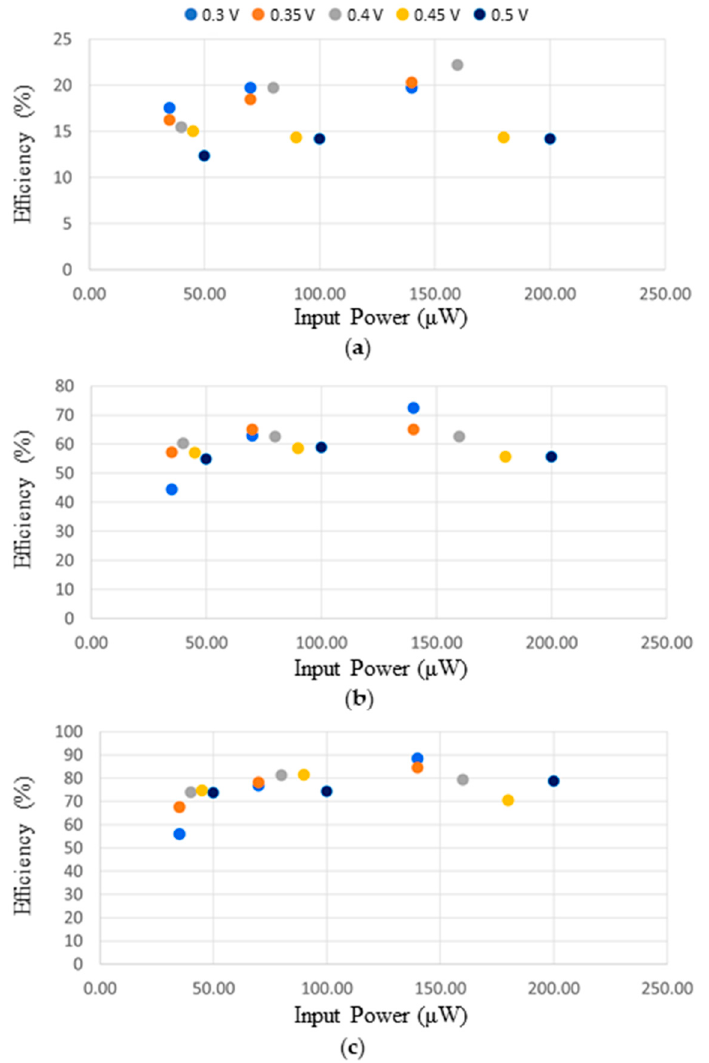
Figure 8. Node’s charging efficiency, versus input power, for different halved open circuit volt- ages and configurations: ( a ) exit cold-start, ( b ) first power-on, ( c ) fully